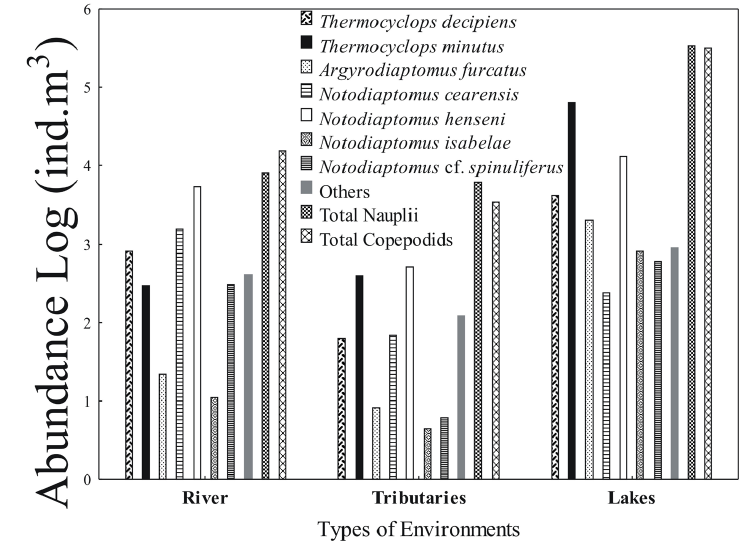
Figure 3. Copepod abundance in the three types of environment sampled. Only the most abundant species were